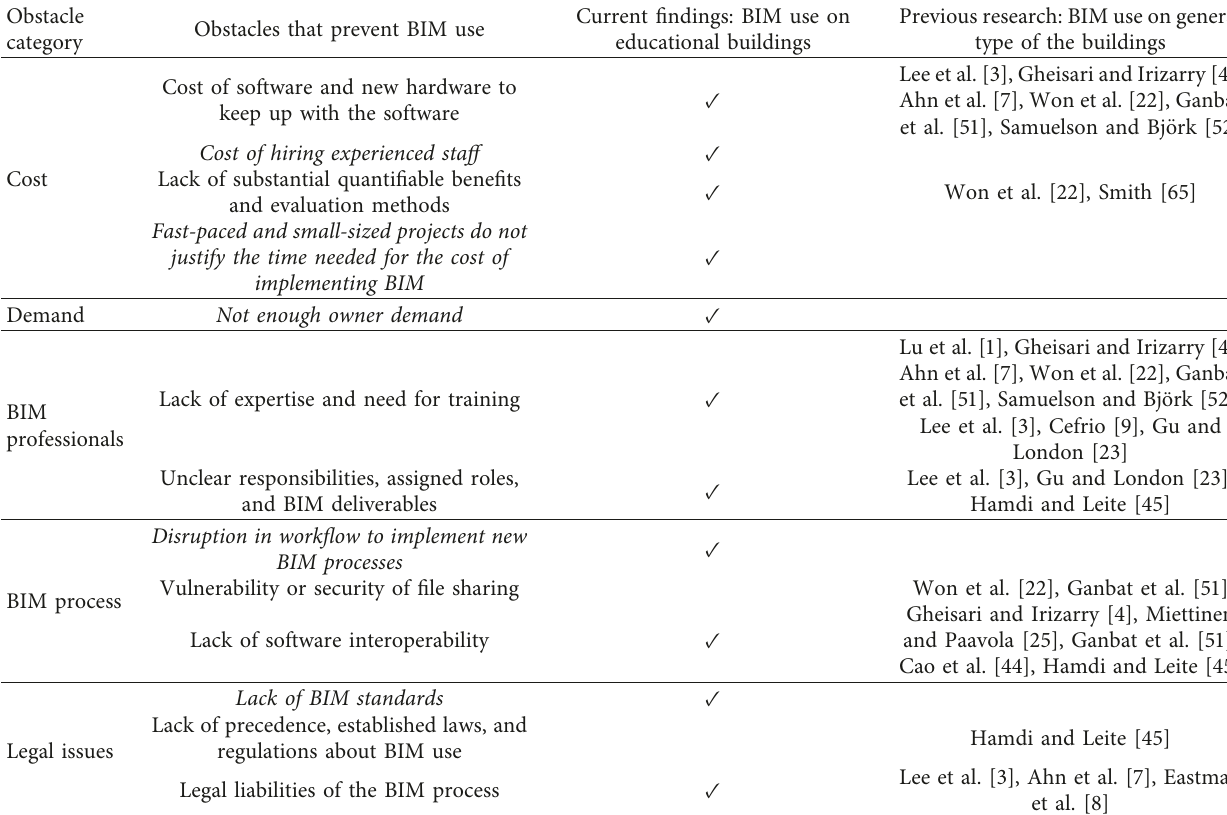
Table 14: Comparison of current findings and previous research: obstacles to BIM use. Obstacle